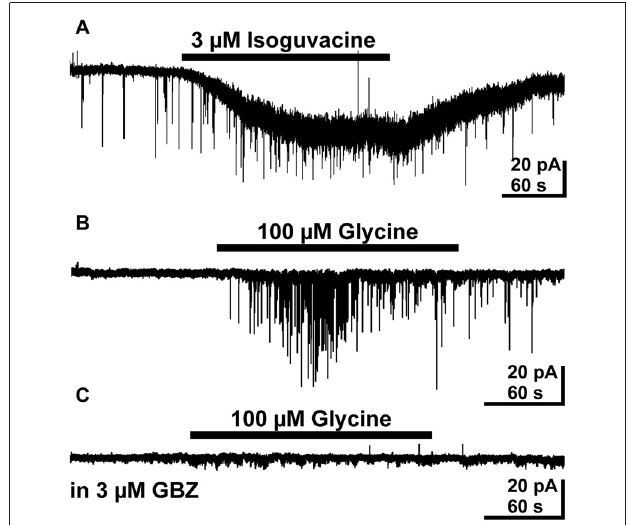
FIGURE 6 | Effect of bath applied isoguvacine and glycine on pyramidal neurons in the presence of 10 µ M CNQX and 20 µ M CPP . (A) Typical current recording demonstrating that bath application of 3 µ M isoguvacine induced an inward current and increased the PSC frequency. (B) Typical trace illustrating that bath application of 100 µ M glycine increased the frequency of PSCs. (C) In the subsequent recording from the same neuron as in B the PSCs induced by bath application of 100 µ M glycine are completely suppressed in the presence of 3 µ M gabazine (GBZ).